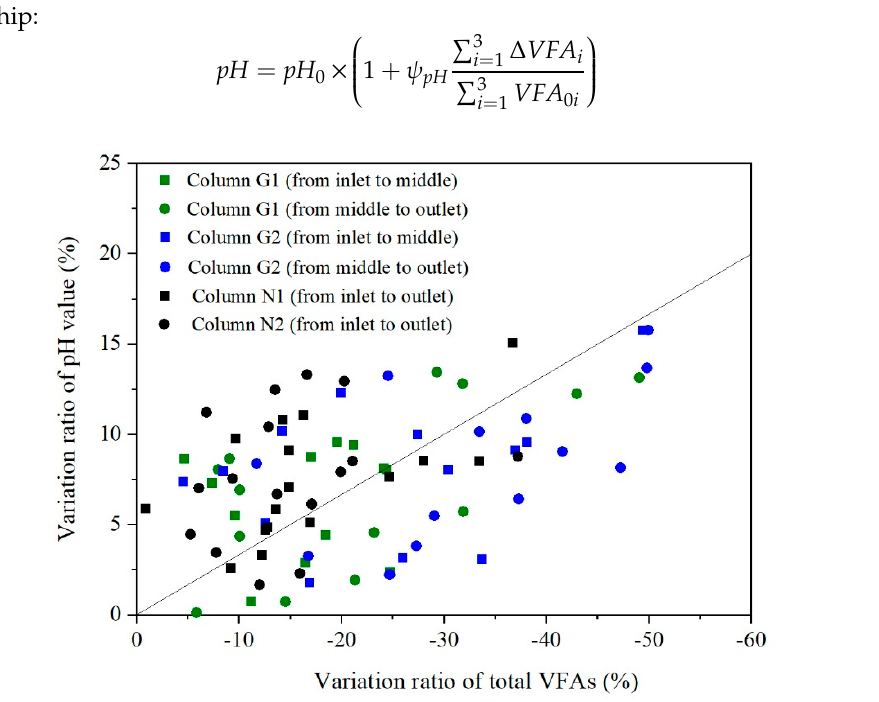
Figure 9. The relationship between pH value and total volatile fatty acids (VFAs) variation.